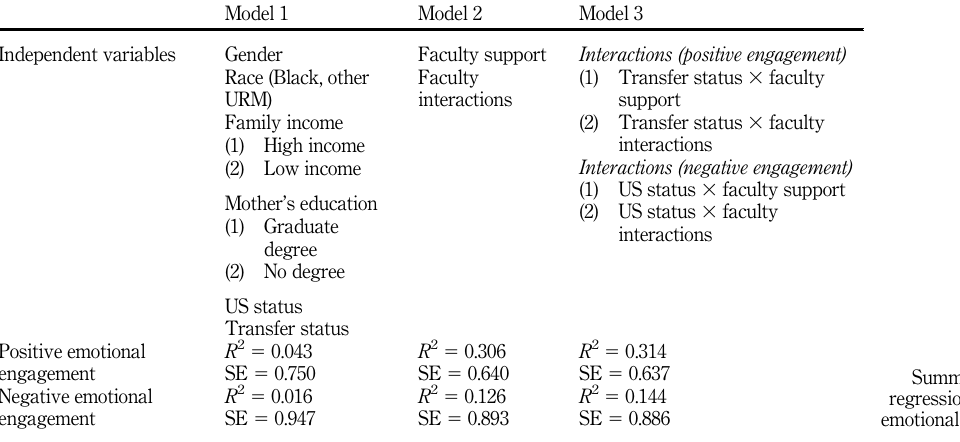
Table 7. Summary of